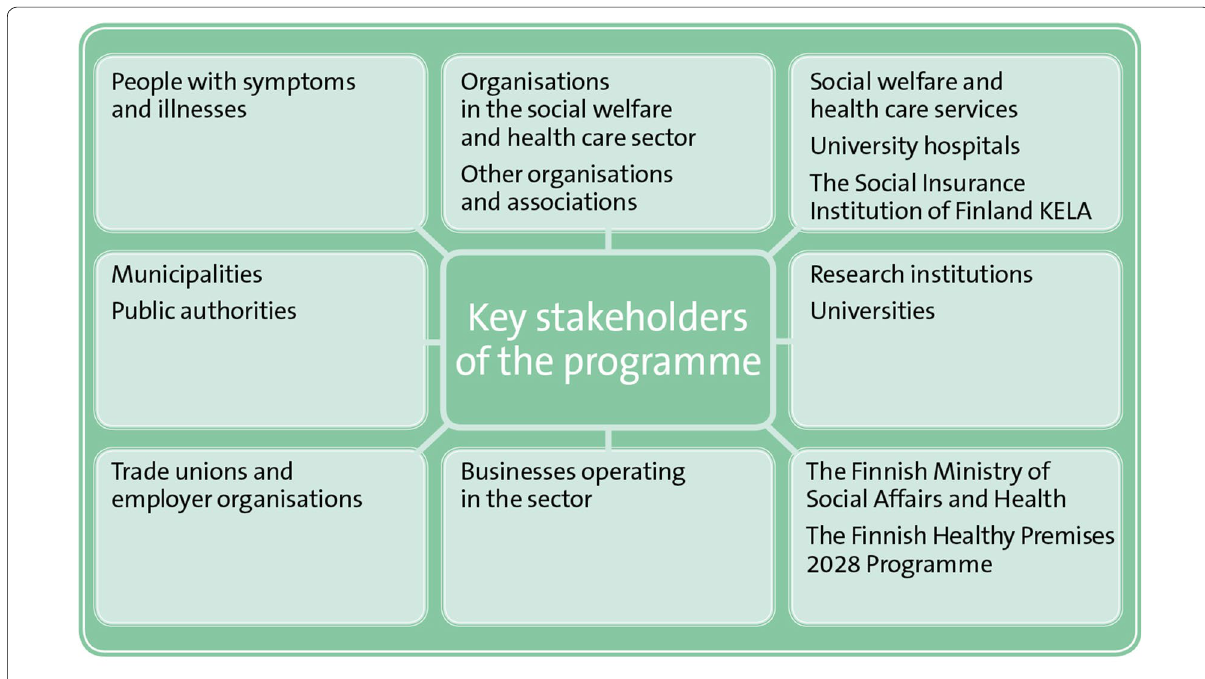
Fig. 11 Key stakeholders of the Finnish Indoor Air and Health Programme